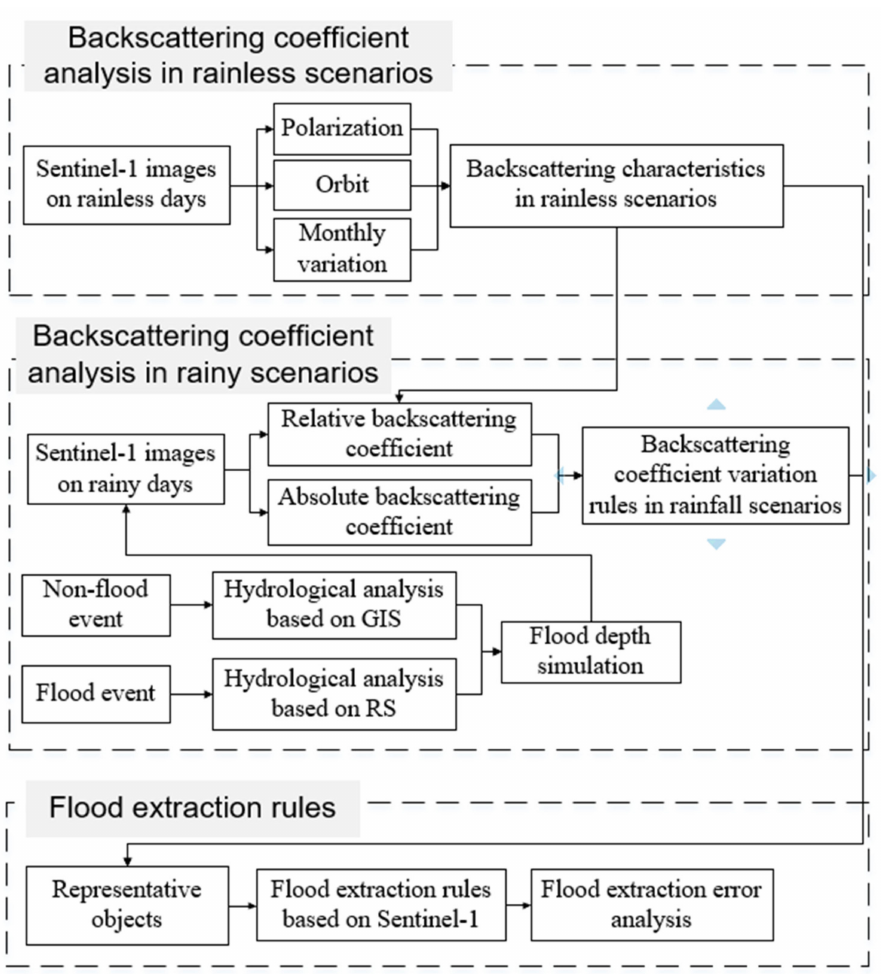
Figure 3. Flow chart of this